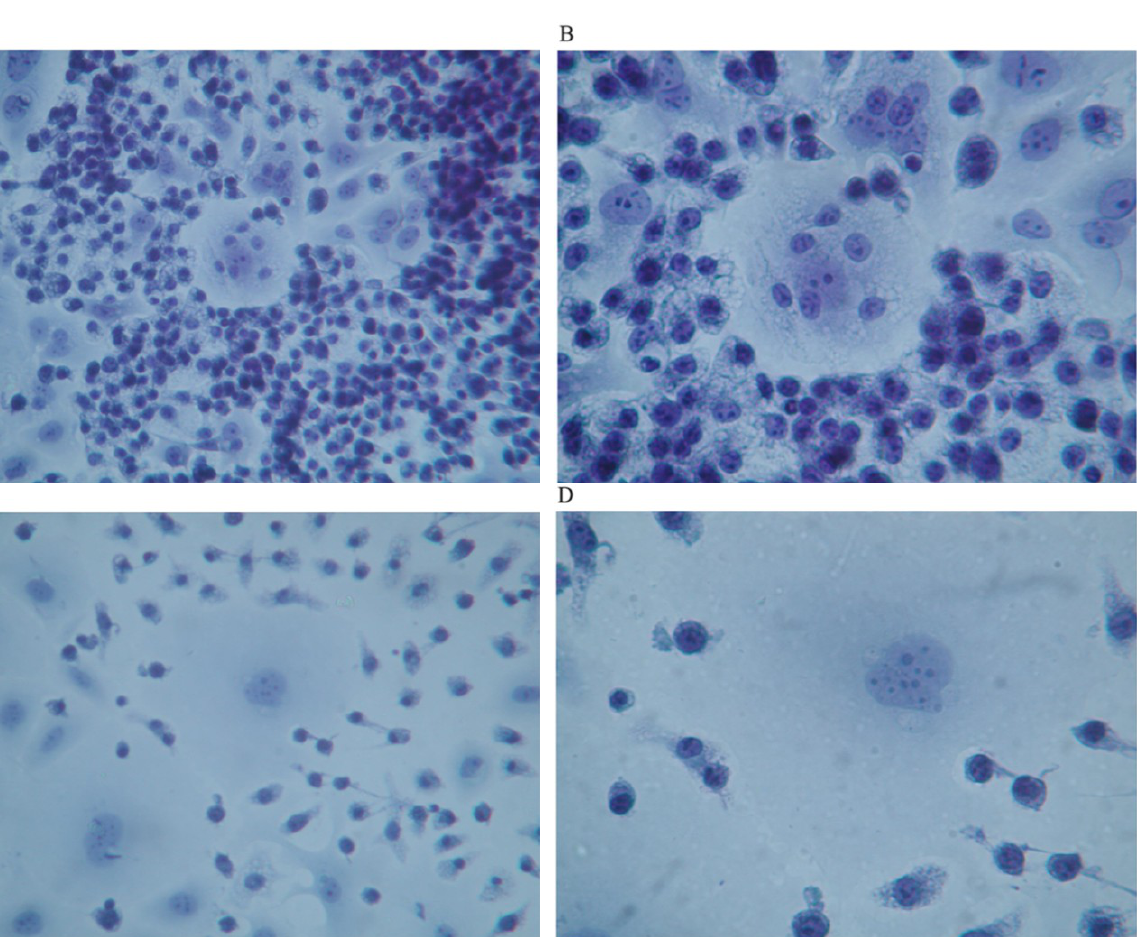
Figure 2. Co-culture of GcMAF-activated macrophages and human breast cancer cells; Papanicolau staining. ( A ) Cancer cells in the center are surrounded by hundreds of small macrophages (100×). ( B ) One human breast cancer cell is completely surrounded by macrophages that are also observable on top of the cell (200×). ( C ) Two large cancer cells are surrounded by GcMAF-activated macrophages (100×). ( D ) The same cell (200×); the chromatin in the nucleus is fragmented and, in the lower right corner, the cytoplasm is to be indented as if the two macrophages in that region were actively deconstructing the cytoplasm of the cancer